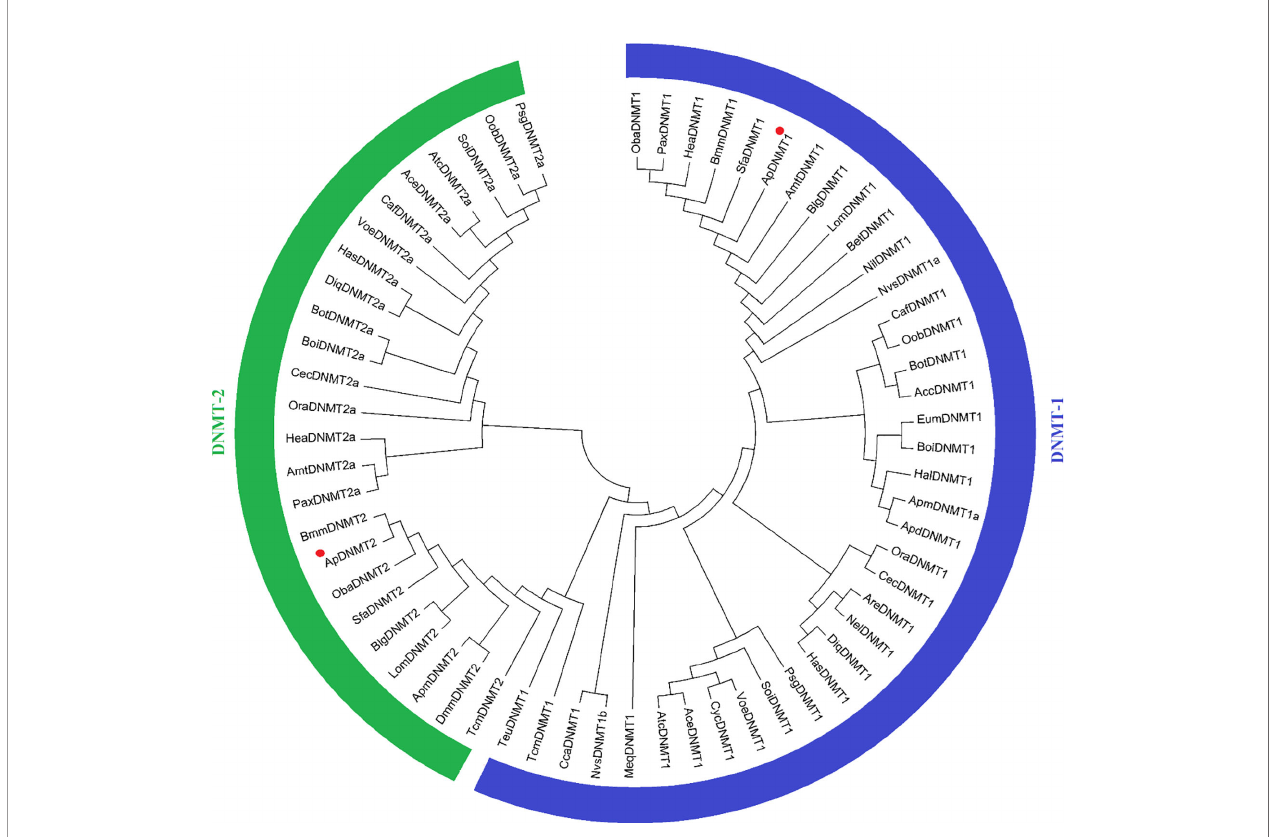
FIGURE 4 | Phylogenetic analysis of A. pernyi ApDNMT-1 and ApDNMT-2 proteins with other DNMT-1 and DNMT-2 proteins from vertebrate and invertebrate species. The deduced amino acid sequences were aligned; later a phylogenetic tree was constructed using the neighbor-joining method.